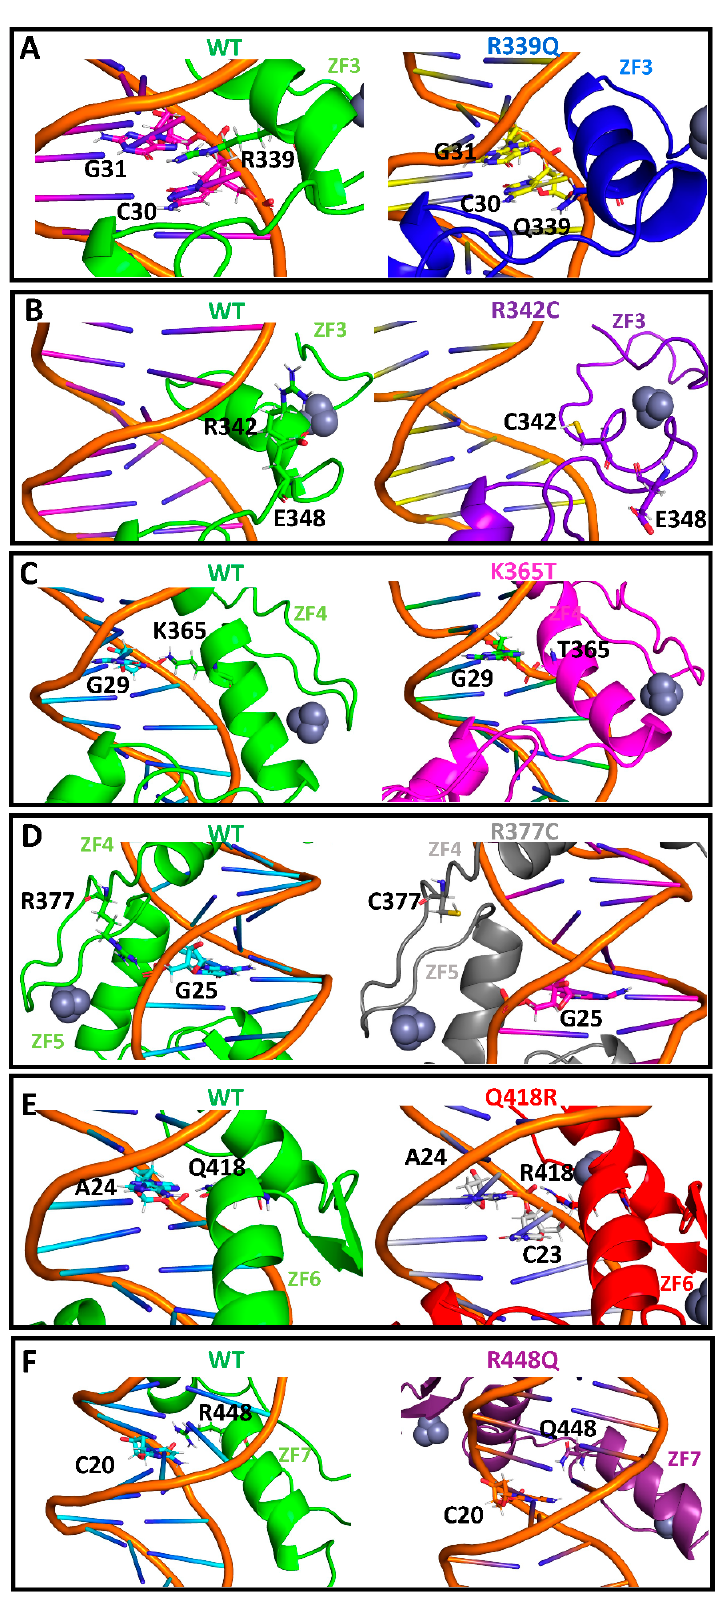
Figure 5. Single-residue mutations affect hydrogen bonding networks between CTCF and DNA. Shown is the 3D structure of the most representative cluster for the WT (all panels, green), R399Q ( A , blue), R342C ( B , violet), K365T ( C , magenta), R377C ( D , gray), Q418R ( E , red), and R448Q ( F , plum) proteins, with specific hydrogen bond interactions.